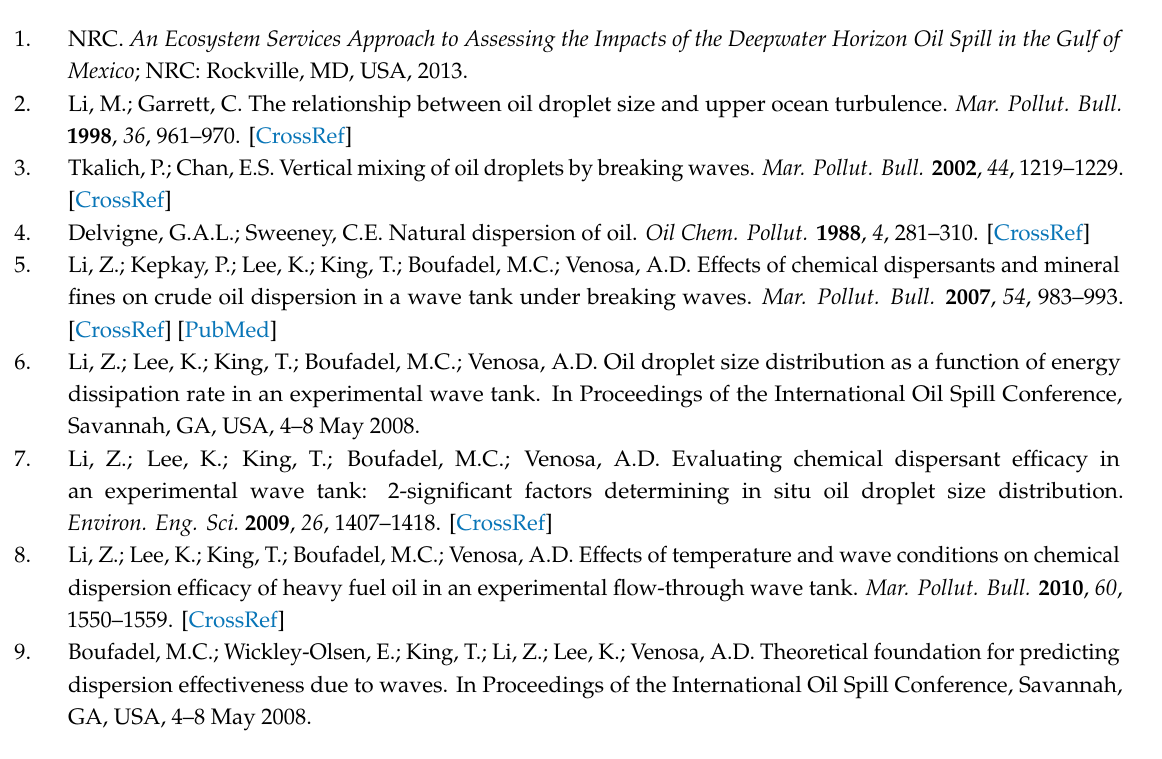
A good agreement is noted between the experimental data and the